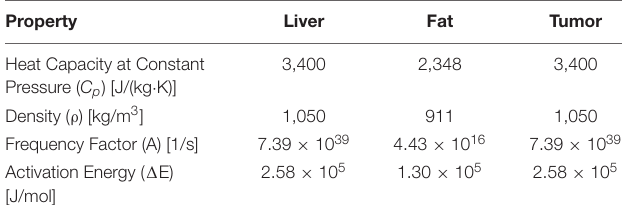
TABLE 1 | Material properties of liver, fat, and tumor.